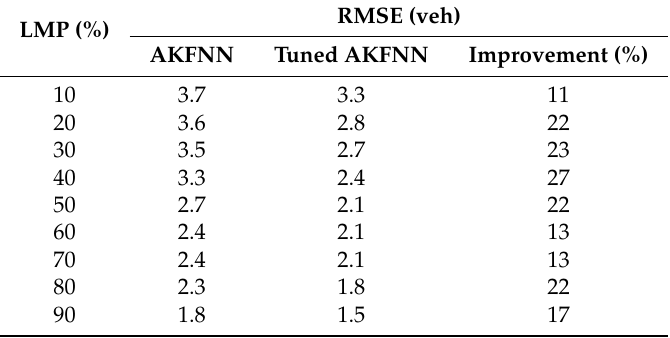
Table 5. Impact of applying the trial-and-error technique for the initial value of covariance P i . LMP